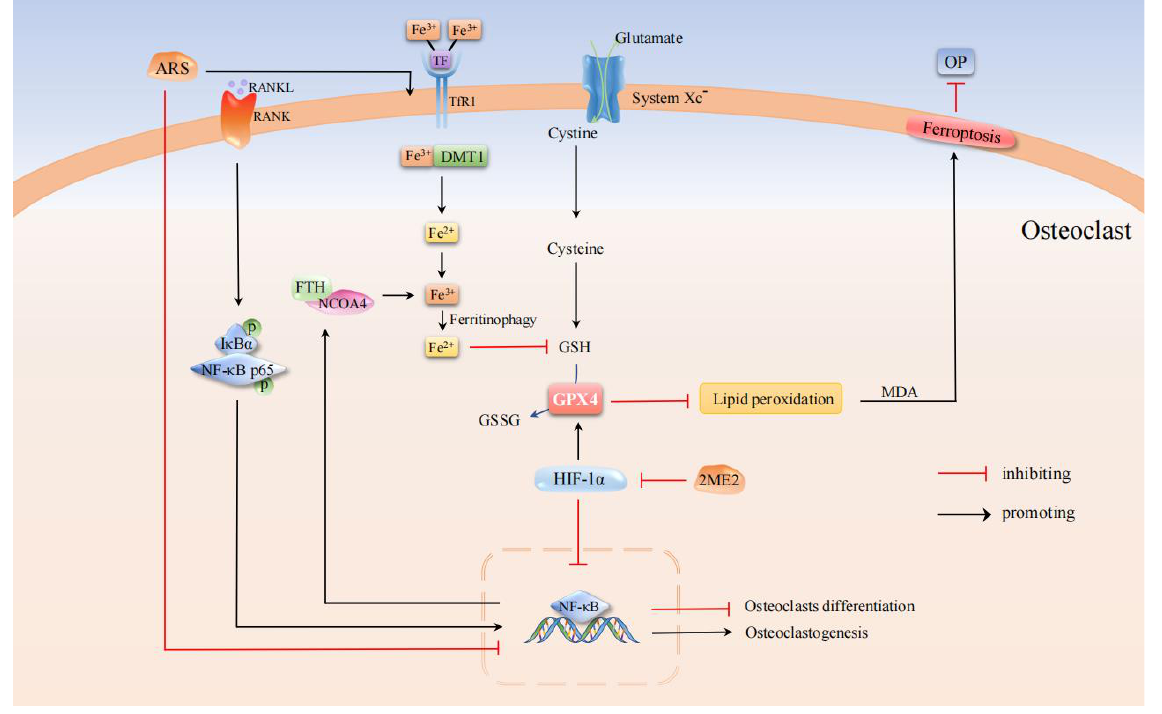
Figure 3. Molecular pathways in the regulation of OP-associated osteoclasts by ferroptosis. 2ME2, the HIF- 1α specific inhibitor, induced osteoclast ferroptosis by increasing MDA and Fe 2+ content